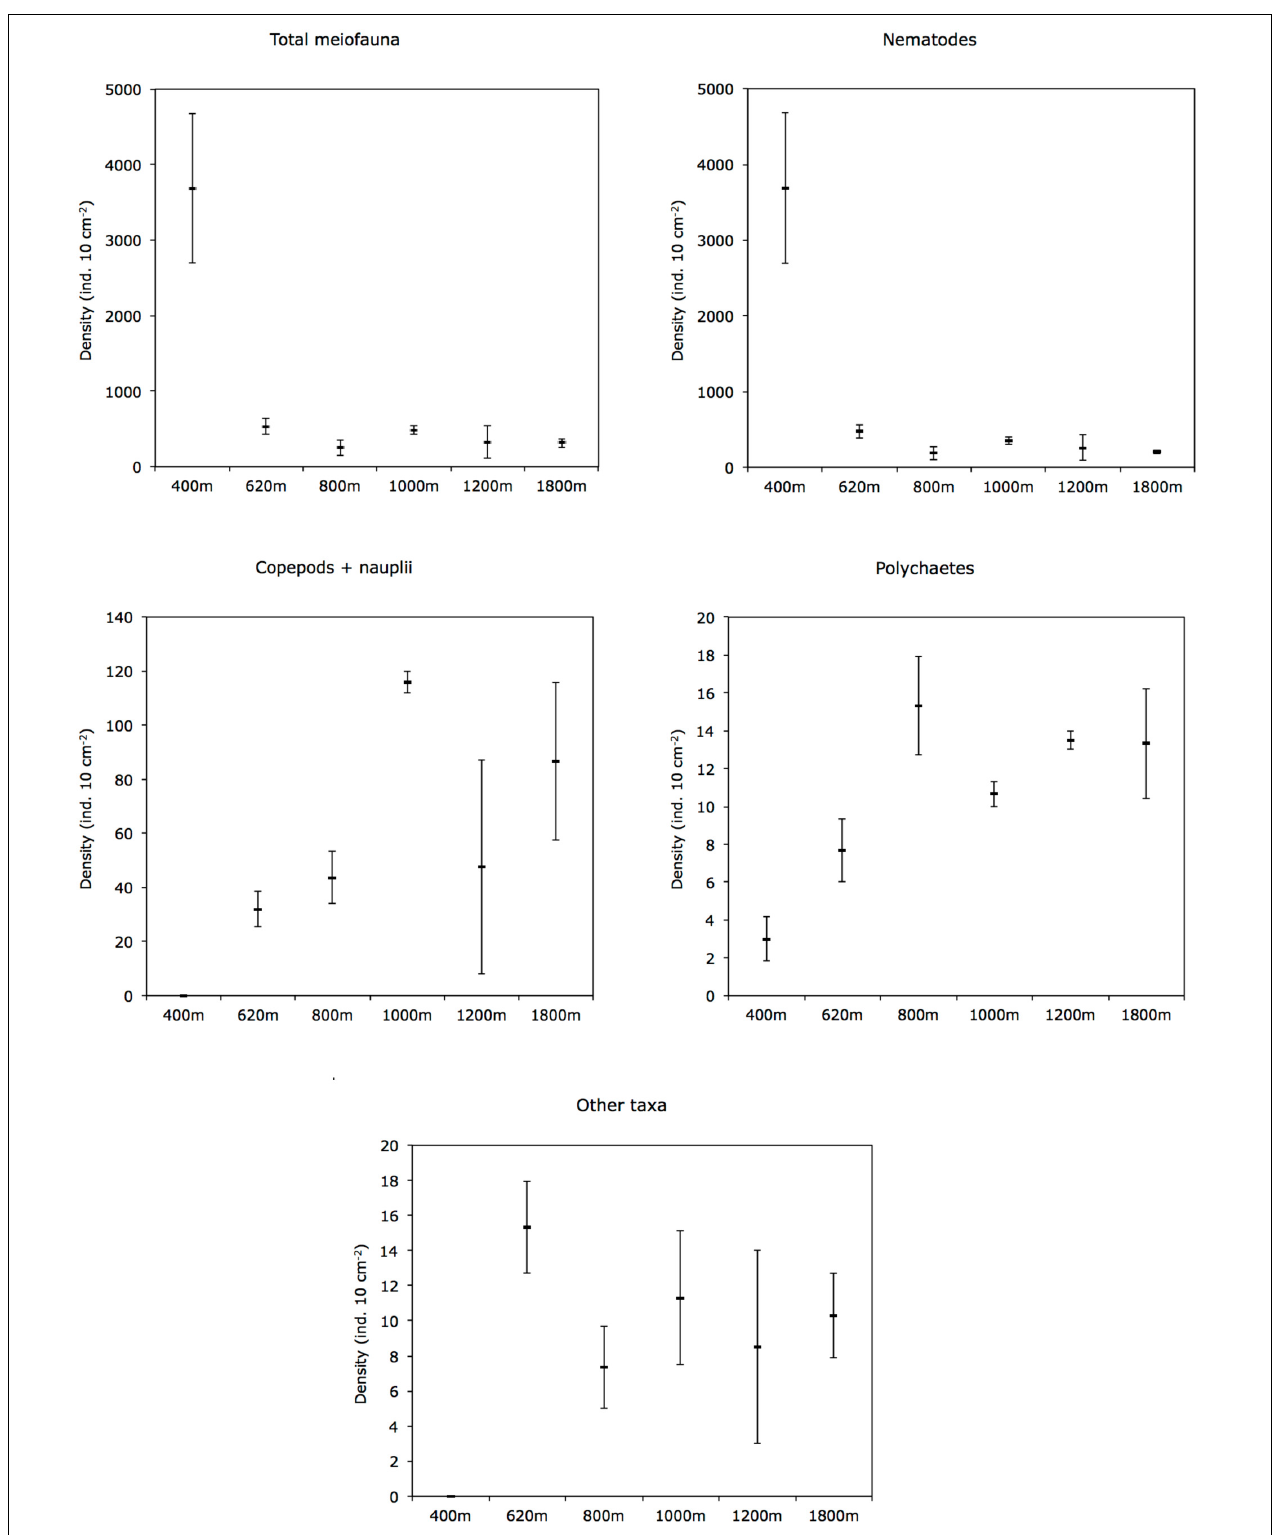
FIGURE 4 | Cross-margin distribution of total meiofauna, nematodes, copepods + nauplii, polychaetes, and other taxa abundances (mean ± 1 SE) in slope sediments (0–10 cm) off Costa Rica. Other taxa include kinorhynchs, ostracods, turbellarians, bivalves, gastrotrichs, oligochaetes, isopods, tanaids, priapulids, aplacophorans, amphipods, cnidarians, gastropods, and cumaceans.